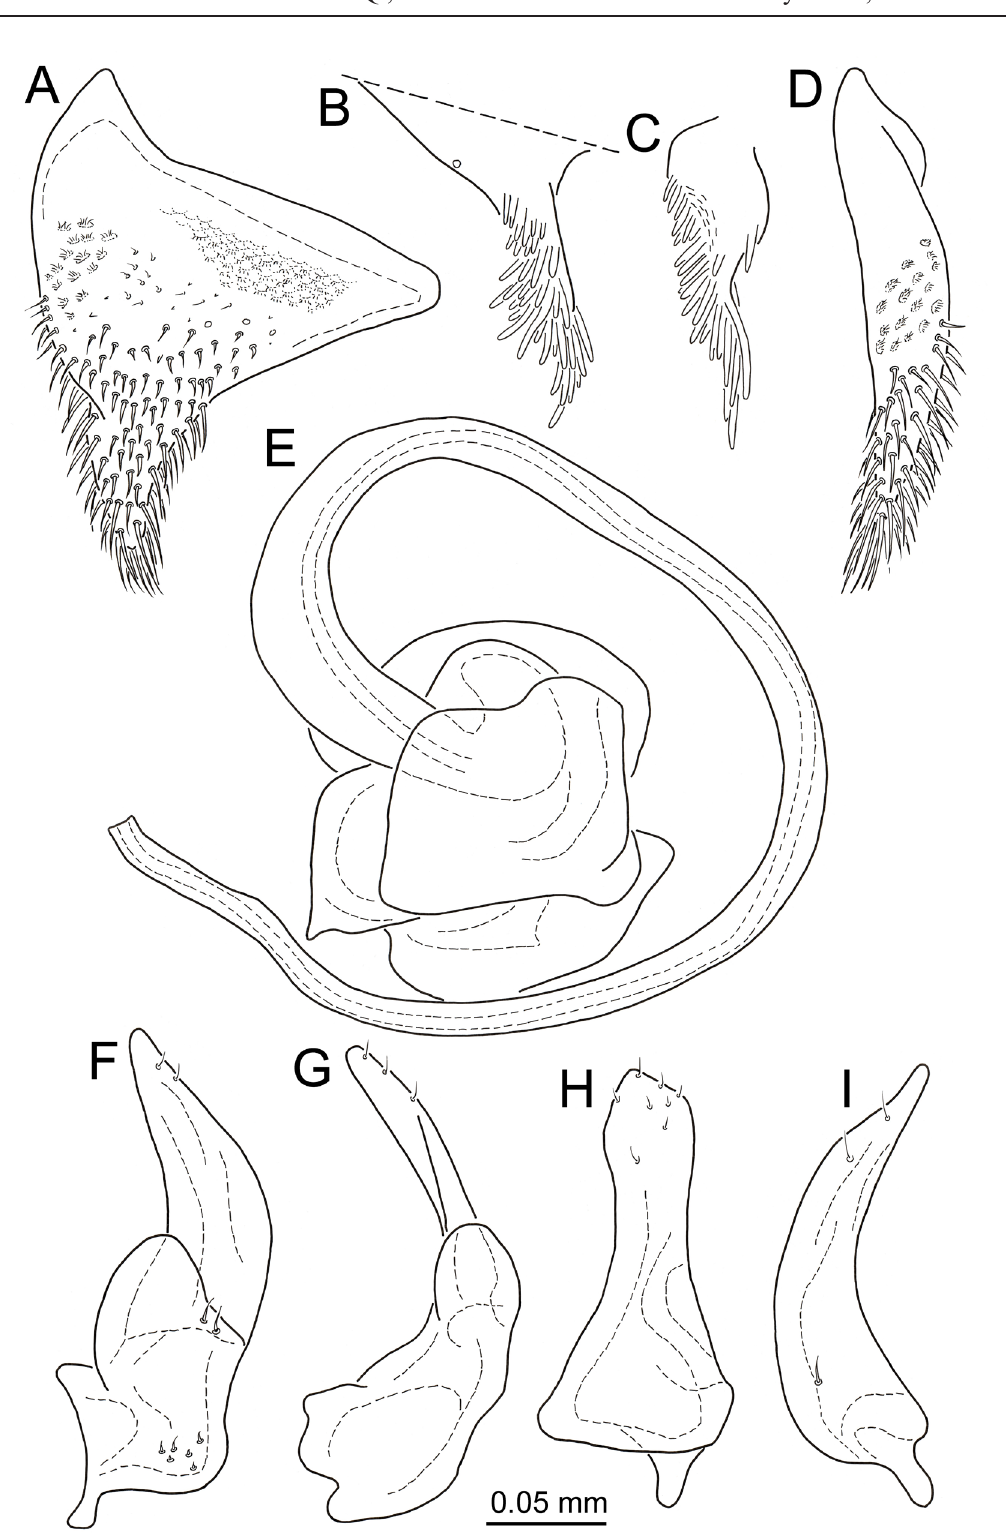
Fig. 20. Kokeshia renae sp. nov., segment VIII and genitalia, paratype, ♂ (SYSBM). A, D . Left hemitergite VIII. A . Dorsal view. D . Left lateral view. B‒C . Apex of right hemitergite VIII. B . Dorsal view. C . Right lateral view. E . Phallus. F‒G . Left paramere, two different aspects. H‒I . Right paramere, two different